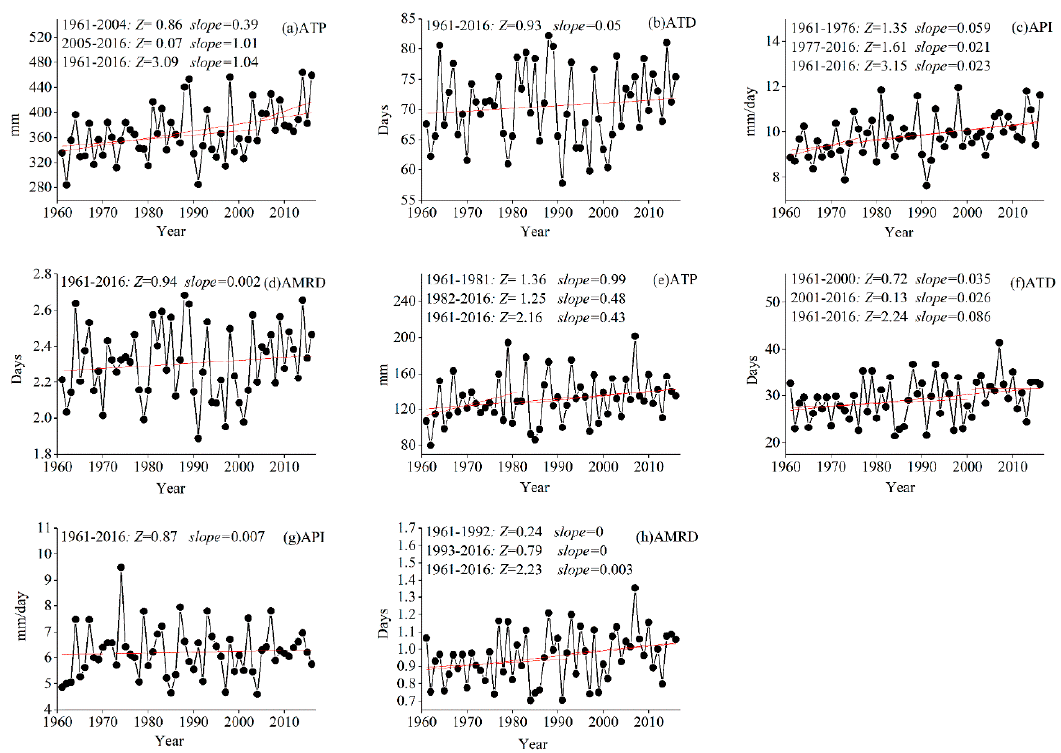
Figure 6. Trend of annual average precipitation indices before and after abrupt change points and over the total period from 1961 to 2016 in the upper (UHRB) ( a – d ) and middle (MHRB) reaches of the Heihe River Basin ( e – h ). (Solid line denotes the linear trend, shading denotes the 95% confidence intervals of the estimated trends). Table 2. The Z value of the precipitation indices, 1961–2016. Station ATP ATD